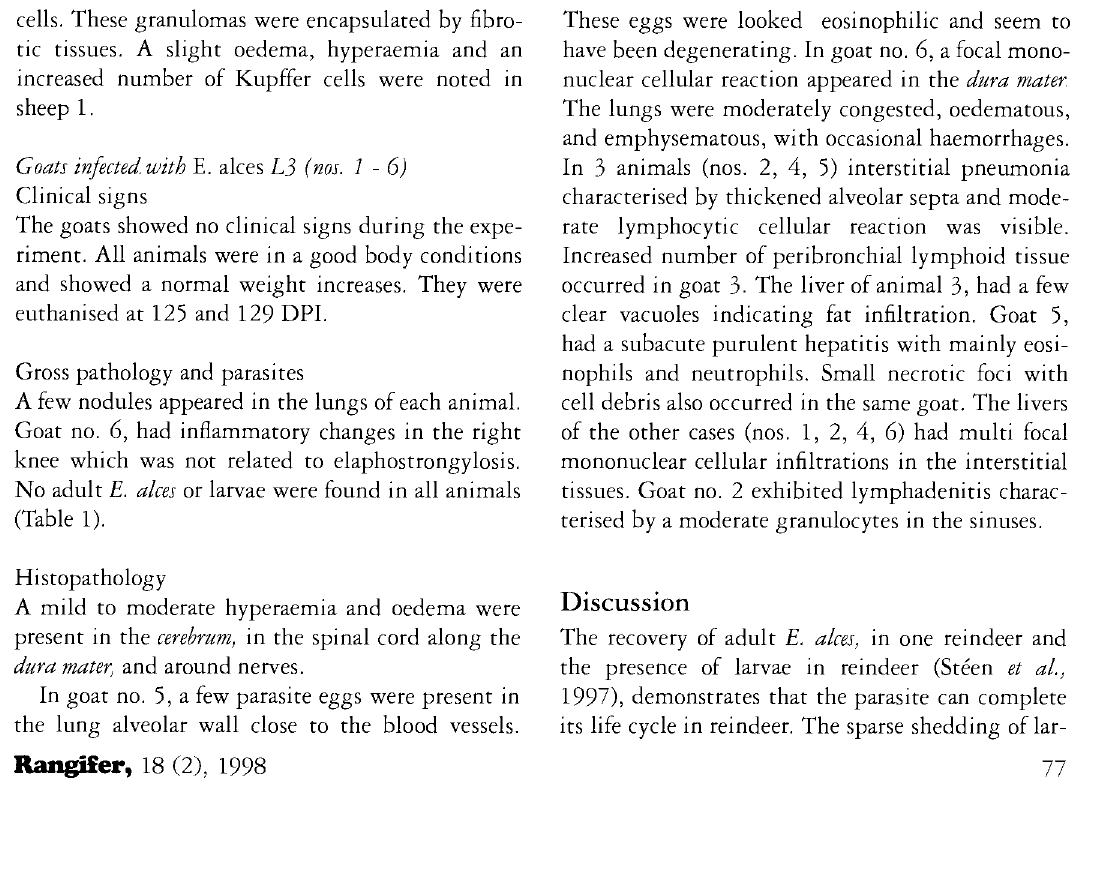
Fig. 2. Severe infiltrates with inflammatory cells were present around nerve bundles in sheep infected with Elapho- strongylus rangiferi (x 400; H &